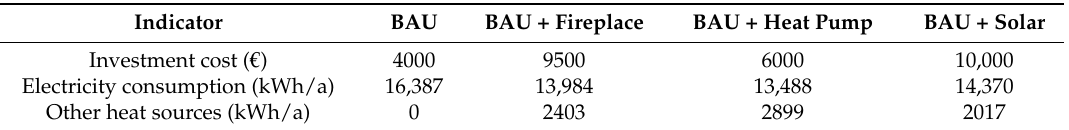
Table 2. Key figures concerning the heating systems in the different cases. BAU stands for Business as usual.